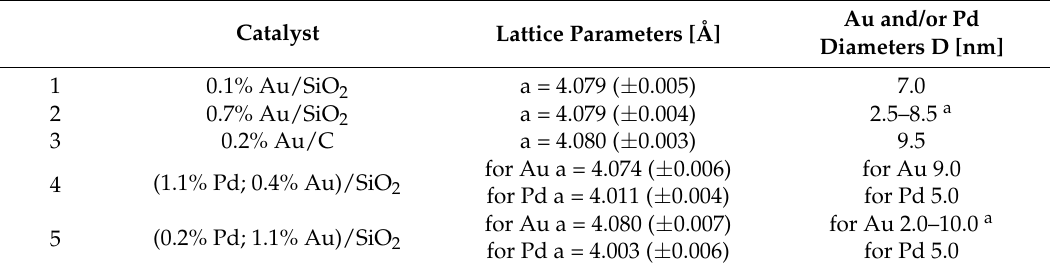
Table 2. Mean diameters (D) and lattice parameters (Å) of the nano-Au and Pd particles in the resulting catalysts as confirmed by XRD